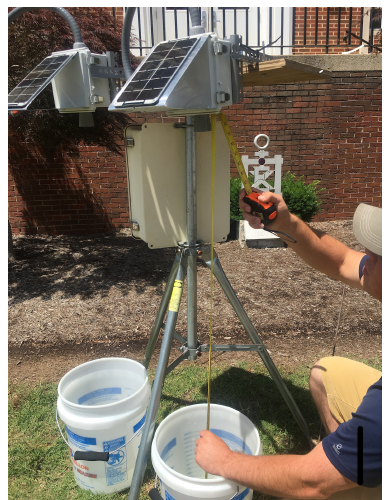
Figure 3. Field test of the sensor prototype.